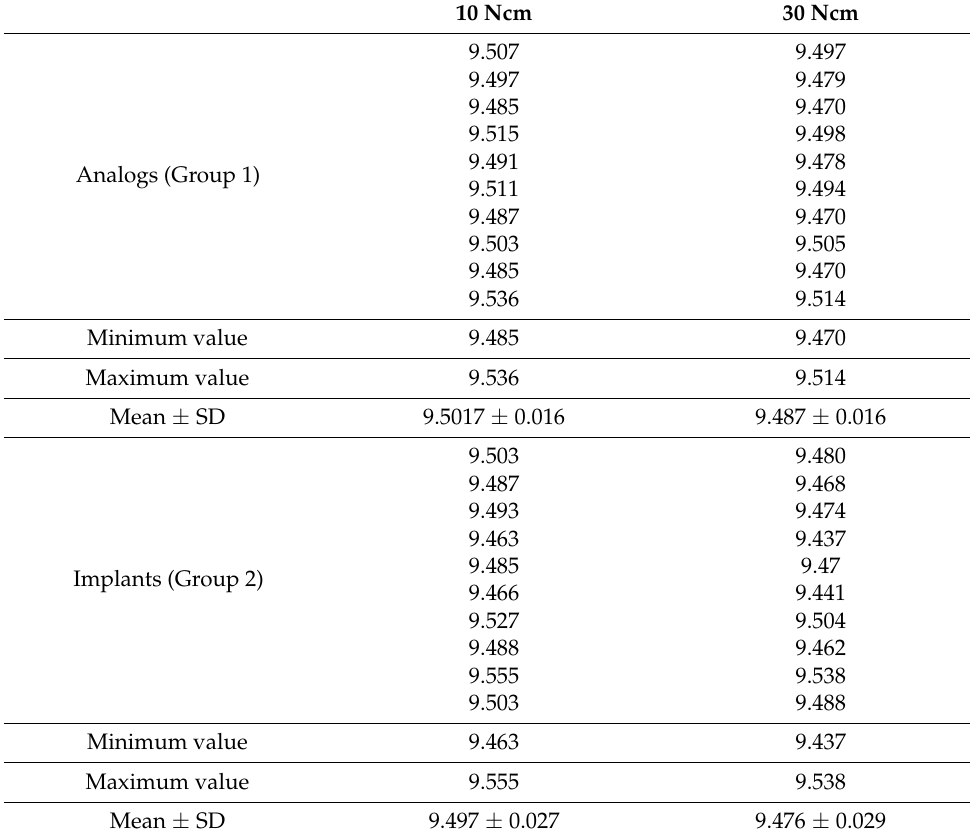
Table 1. Individual values of distances between points A and B